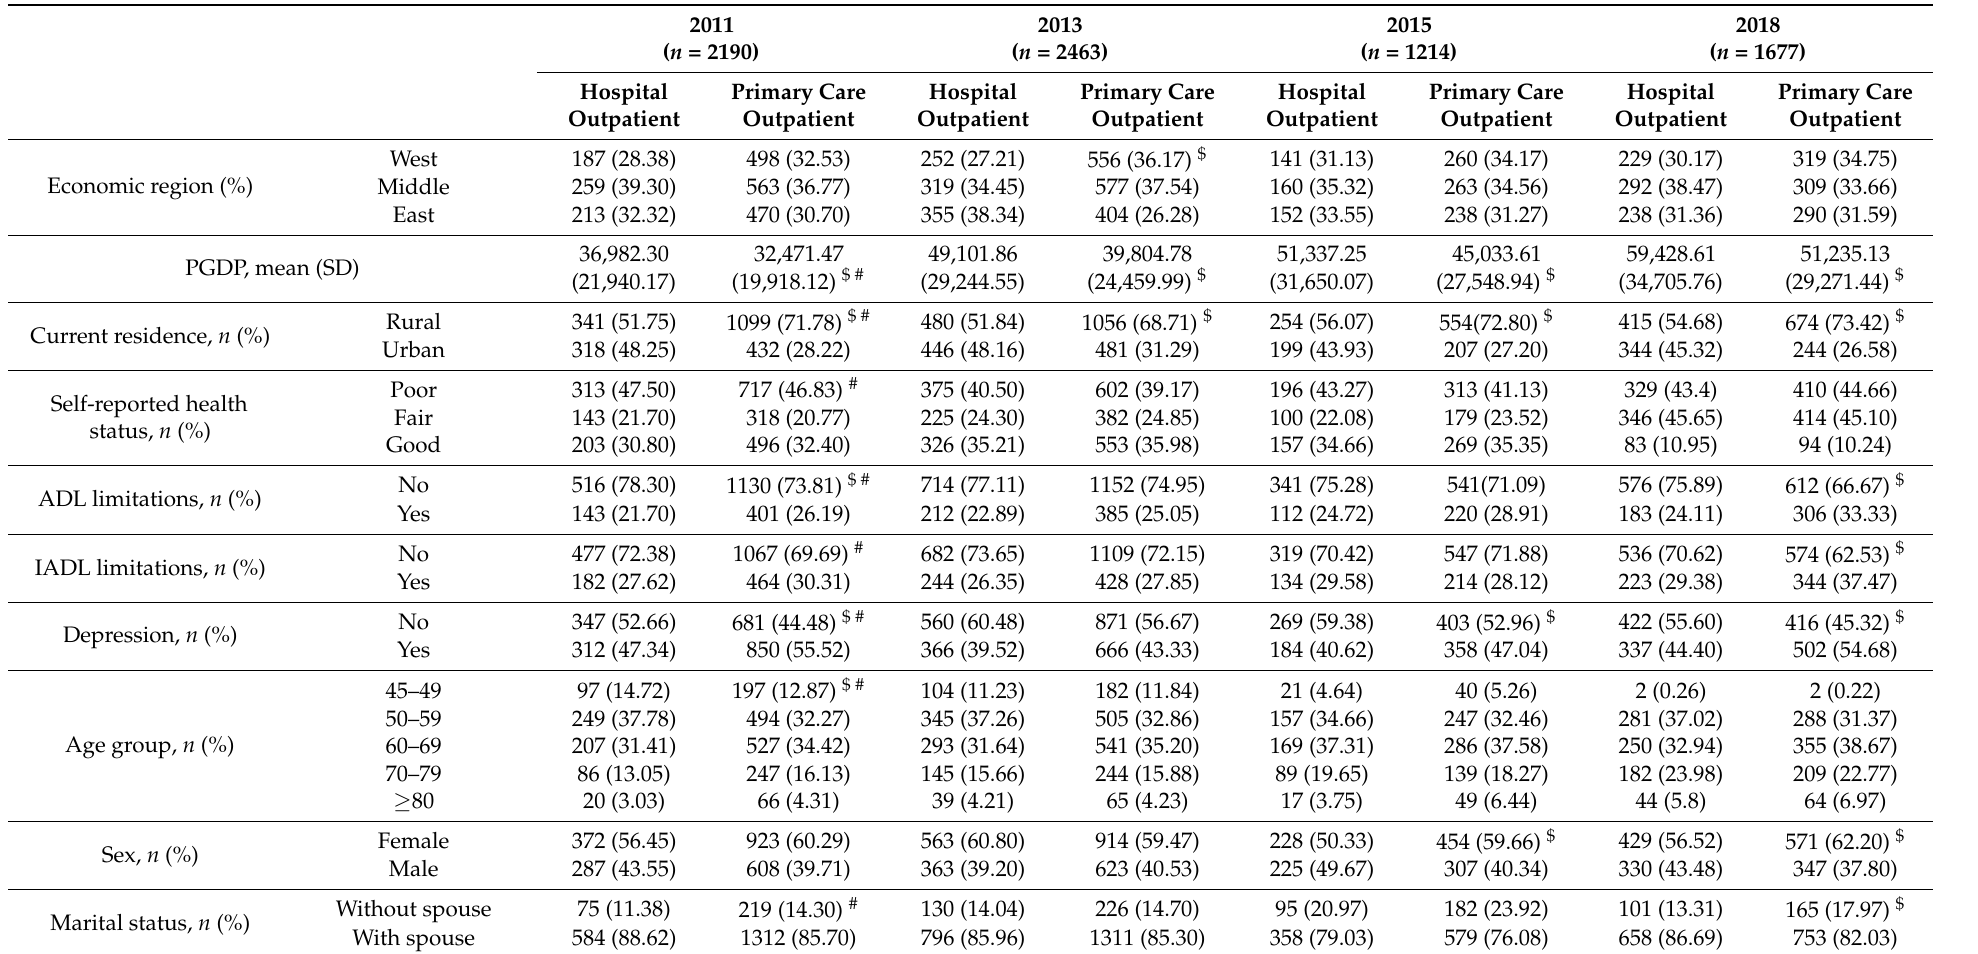
Table 1. Descriptive statistics of covariates in each wave,